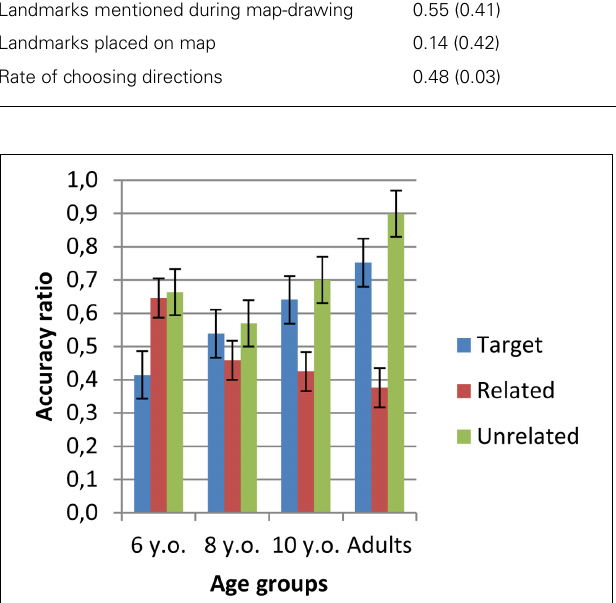
FIGURE 7 |Accuracy ratio for targets, related and unrelated distractors by age.